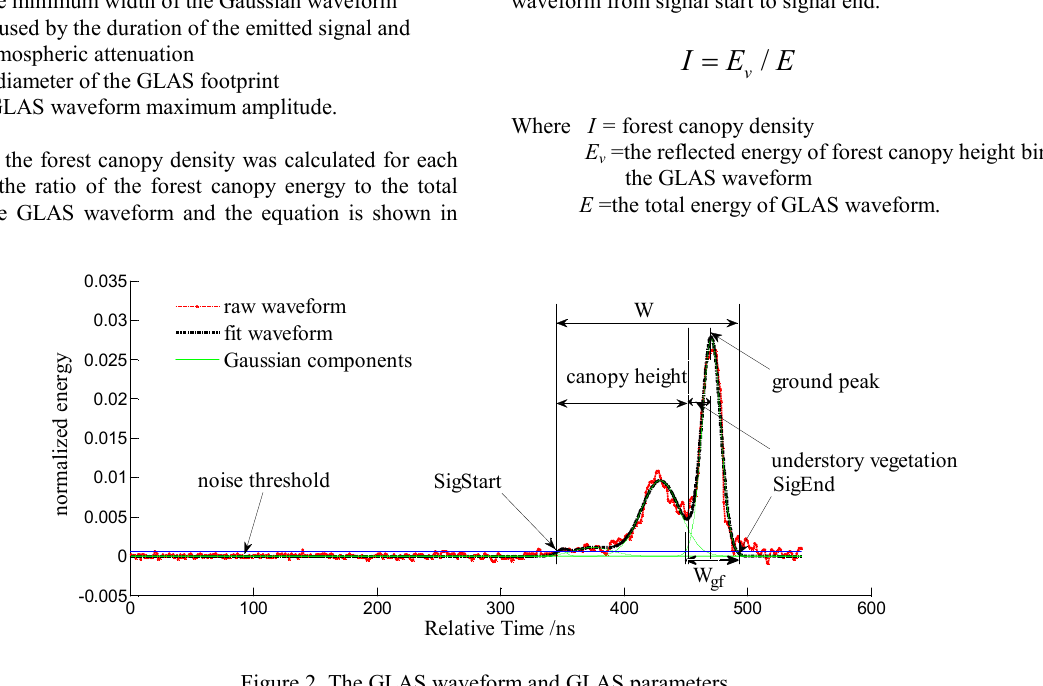
Figure 2. The GLAS waveform and GLAS